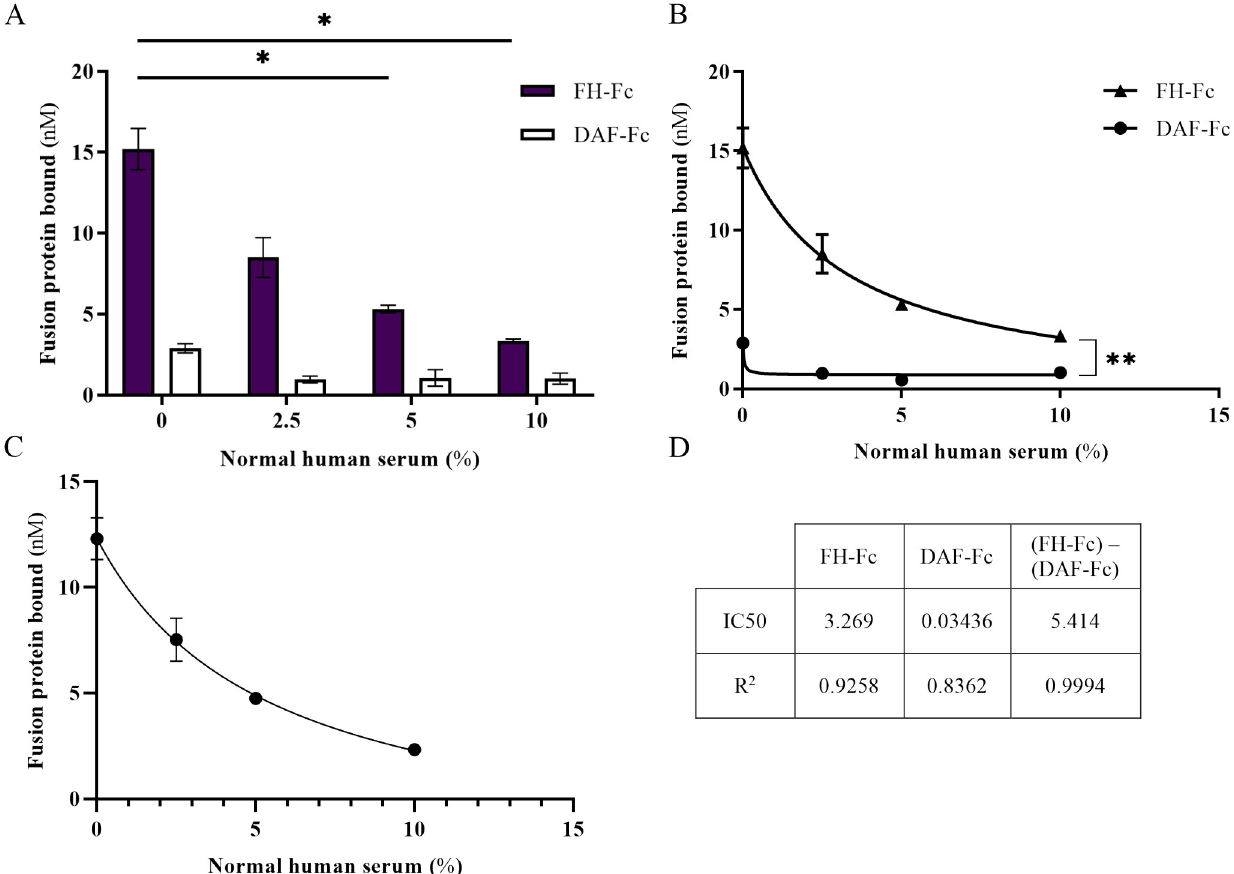
Fig 4. FH-Fc competes with serum for binding to CA-MRSA R7. A, Fluorescently labeled FH-Fc and DAF-Fc (62.5 nM) bound by R7 in the presence of increasing serum amounts, measured by fluorescence detection. B, Dose response curves of fluorescently labeled FH-Fc and DAF-Fc (62.5 nM) bound by R7 in the presence of serum. C, Dose-response curve of FH-Fc binding via FH-region, calculated by subtracting bound DAF-Fc from bound FH-Fc. D, IC50 and R 2 of dose-response curves (B and C). Data represent a minimum of three independent experiments ± SEM, � p < 0.05, �� p � 0.004. chemistry to label the N-linked glycans of both FH-Fc and a control protein with a small fluo- rescent dye (720 Da) to minimize label-induced binding hindrances. DAF-Fc was selected as the control for the fluorescent studies due to its glycosylation-site equivalence to that of FH-Fc. CA-MRSA R7 bacteria were incubated with a constant amount of labeled fusion pro- tein (FH-Fc or control) in various amounts of NHS. As concentrations of NHS increased, a dose-dependent reduction in the binding of FH-Fc to CA-MRSA R7 was evident, with only minimal effect on DAF-Fc binding (Fig 4A and 4C). Dose-response curve data revealed that FH-Fc binding to CA-MRSA R7 was inhibited by 50% using 62.5 nM of FH-Fc and 3.269% of NHS (Fig 3D).